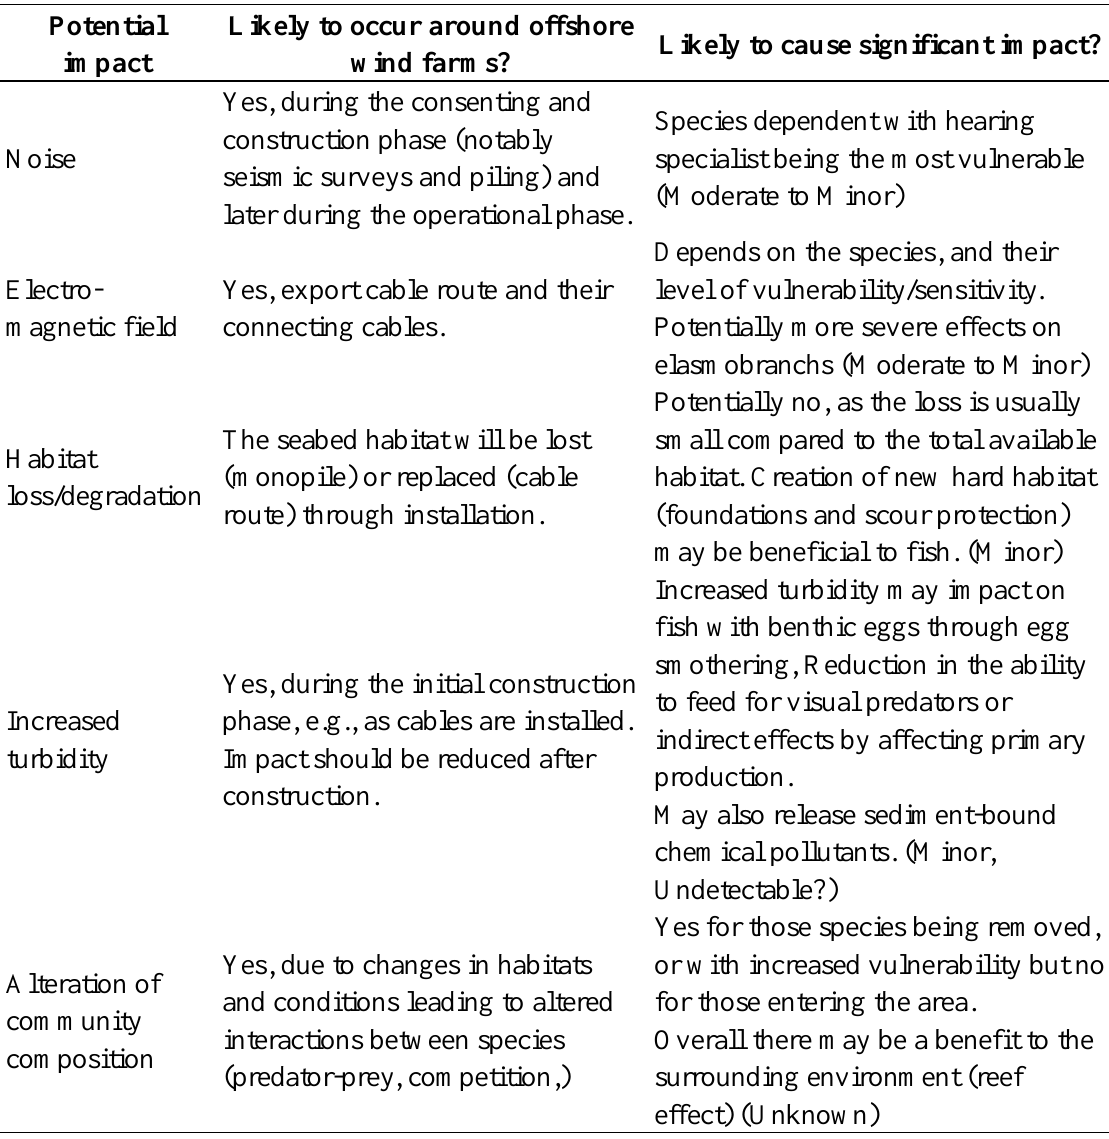
Table 4. Potential impacts of offshore wind farms: marine fishes (Modified from [12]). The evaluation of the severity of impacts is presented between brackets,